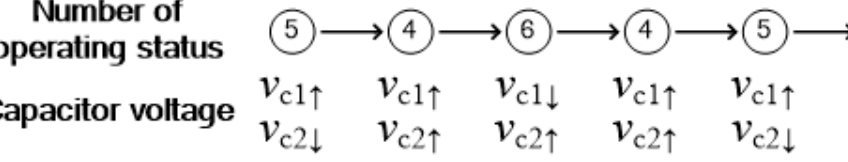
Figure 5. Number of operating status and capacitor voltage behavior of proposed MPC method during period with converter voltage v ab between V dc /2 and V dc .